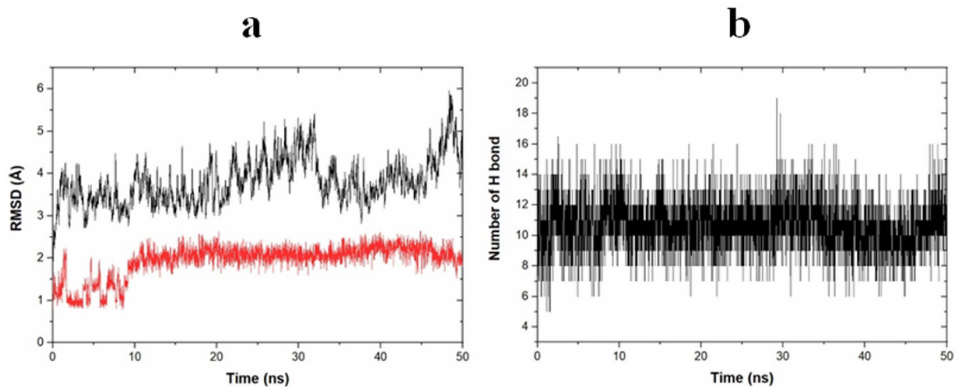
Figure 6. ( a ) Root mean square deviations (RMSDs) of protein backbone in black and ligand in red and ( b ) number of hydrogen bonds between protein and ligand with respect to 50 ns molecular dynamic simulation.